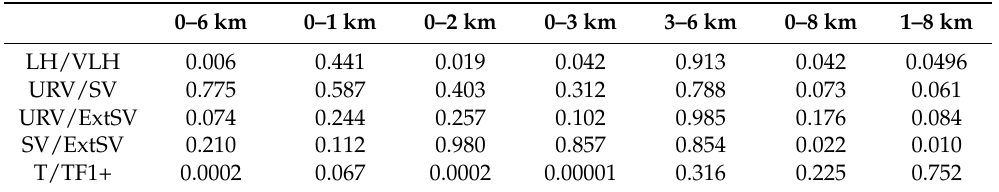
Table 1. The statistical significance ( p ) of the differences between the wind shear means (medians) for the various severe weather events and the particular wind shears. p < 0.05 is bolded. LH, large hail; VLH, very large hail; URV, unrated wind; SV, severe wind; ExtSV, extremely severe wind; T, tornado; TF1+—tornado with rating at least F1.